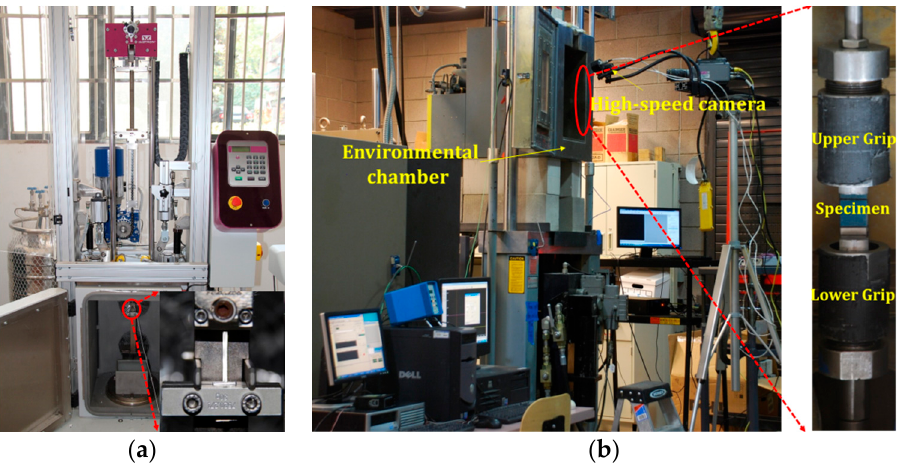
Figure 3. Experimental setup: ( a ) Instron drop-weight impact system; ( b ) Mechanical Testing & Simulation (MTS) servo-hydraulic high speed testing machine.